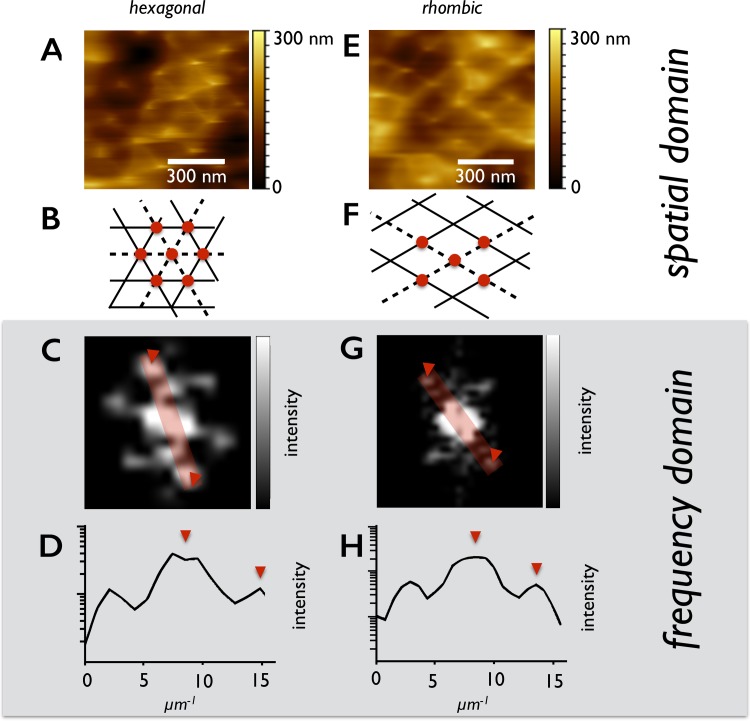
AFM images of different lattice structures of microvilli—Contact mode.The hexagonal (A) and the rhombic (E) lattice structure of the microvilli in the spatial domain imaged by atomic force microscopy. (B) and (F) show the elementary cell of the lattice structure. The red dots represent the microvilli and the lines the lattice planes. (C+G) show the Fourier transformation of (A+E) windowed by the Hann function. The Fourier representations are zoomed into the first Brillouin zones. (D+H) are the plotted profile lines of the red rectangles displayed in the Fourier representations (C+G).